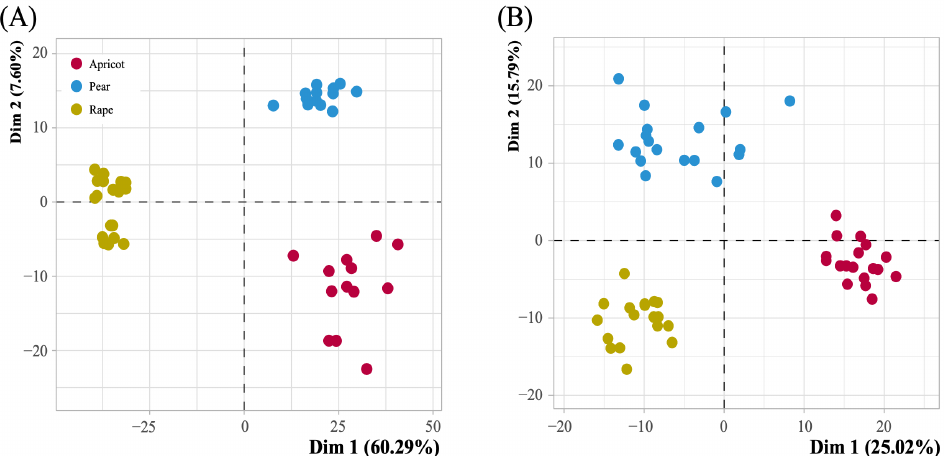
Figure 2. PCA score plots from multivariate statistical analysis. ( A ) Score plots for hemolymph metabolites after 7 days of bee pollen feeding (number of apricot, rape, and pear samples: 13, 17, and 13, respectively). ( B ) Score plots for hemolymph metabolites after 14 days of pollen feeding (number of apricot, rape, and pear samples: 17, 18, and 17, respectively).